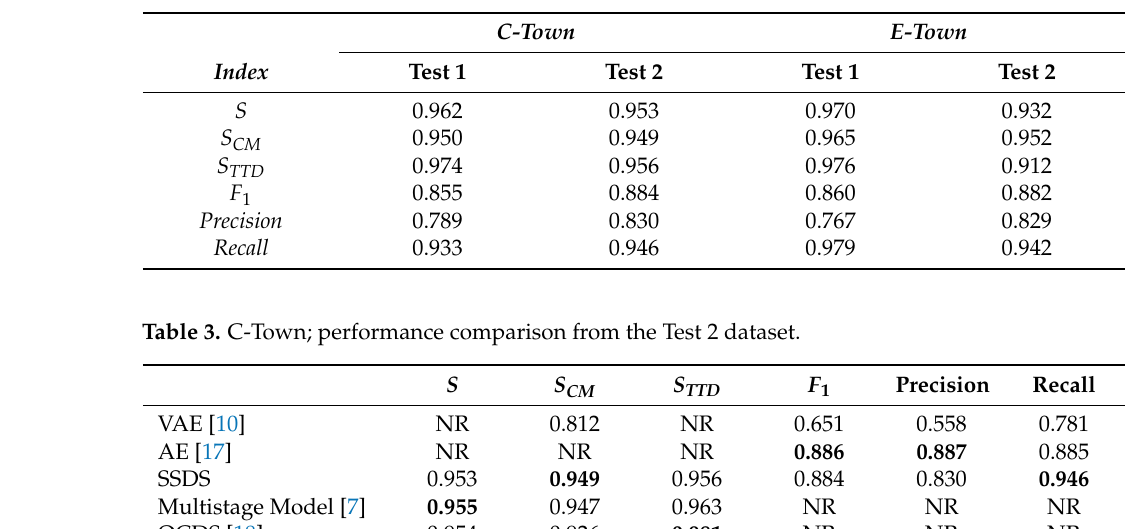
Table 3. C-Town; performance comparison from the Test 2 dataset.